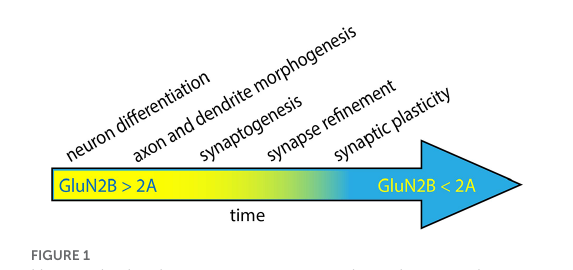
FIGURE1 Neuronal development progresses through several steps, coinciding with the period of high expression of GluN2B. During the early stages of development, GluN2B levels progressively increase, while GluN2A levels are low ( yellow ). As neurons mature, GluN2A levels increase and ultimately surpass GluN2B expression ( blue ). GluN2B has been proposed to play a role in neuronal differentiation, dendrite morphogenesis, synaptogenesis, circuit refinement, and synaptic